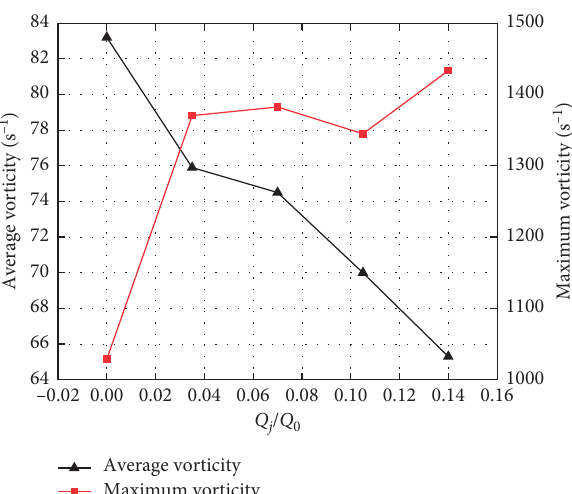
Figure 12: The average vorticity and maximum vorticity changes of nozzles under different jet flow rates.